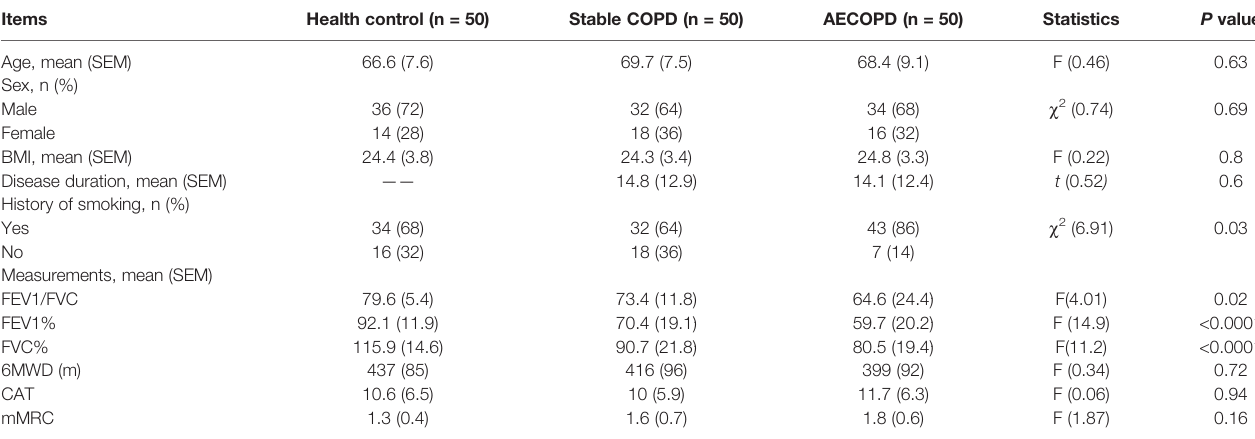
TABLE 1 | Basic demographic characteristics and measurements of the study